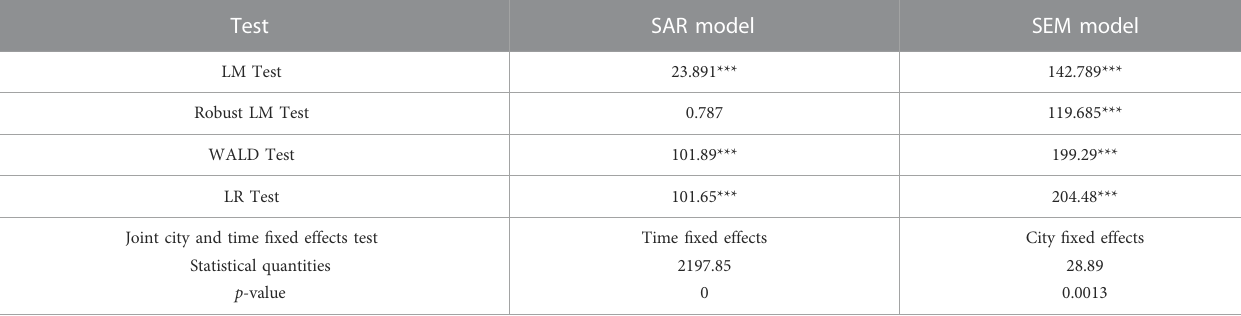
TABLE 5 Results of selected tests of the model.